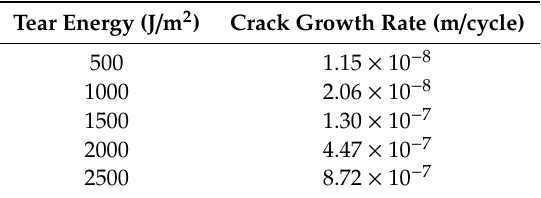
Table 4. Fatigue lives ( N f ) and crack precursor sizes for different samples. Sample